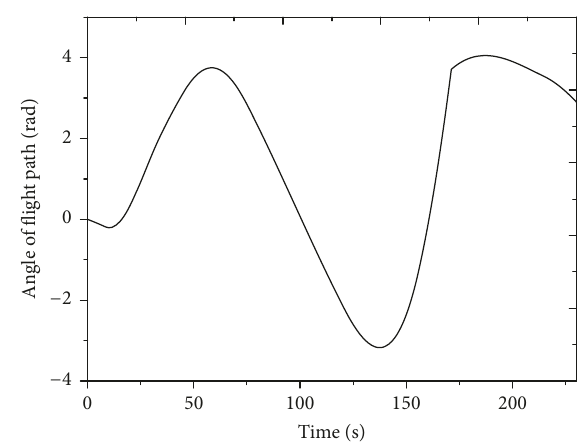
Figure 3: The profile of the angle of flight